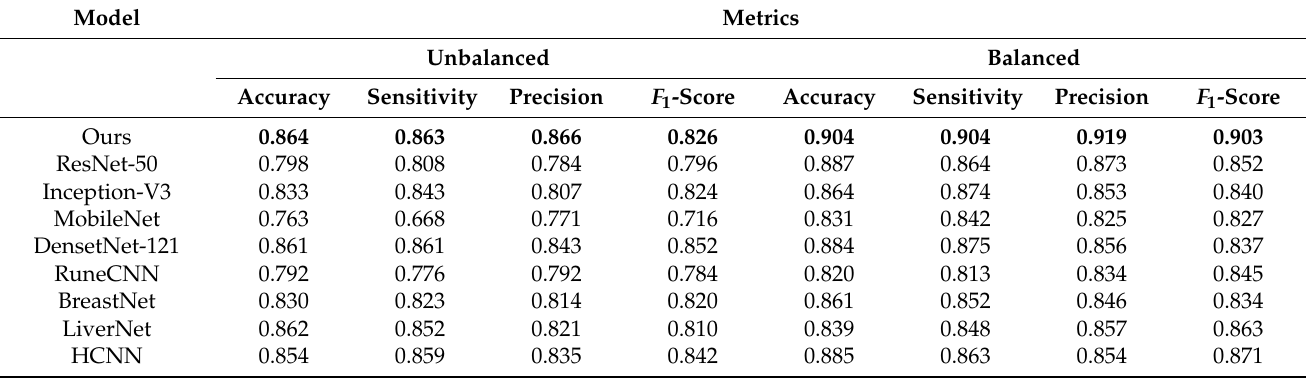
Table 5. Comparison of four metrics on the ICIAR2018 for the binary-classification. The best results are shown in bold